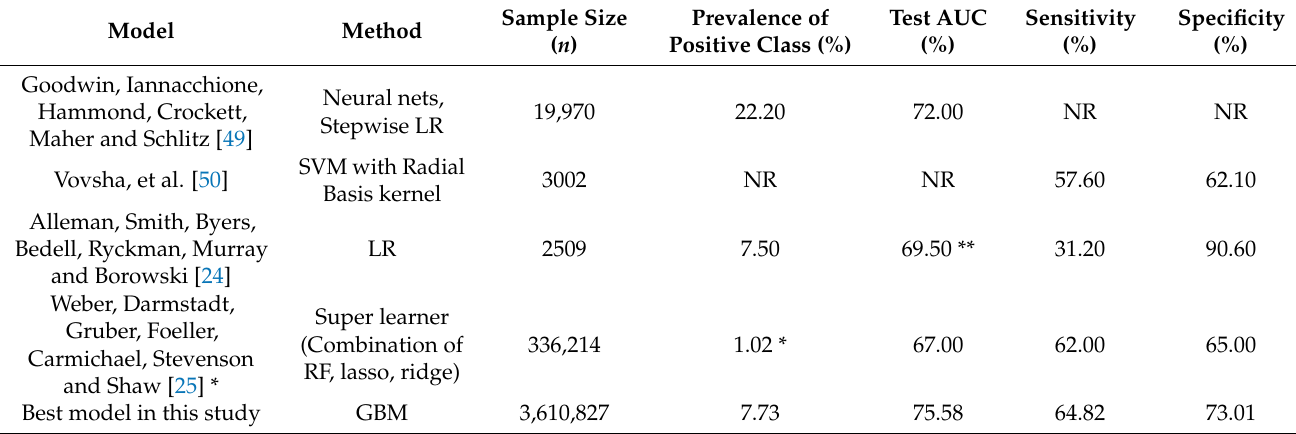
Table 4. Performance comparison with the most related studies.